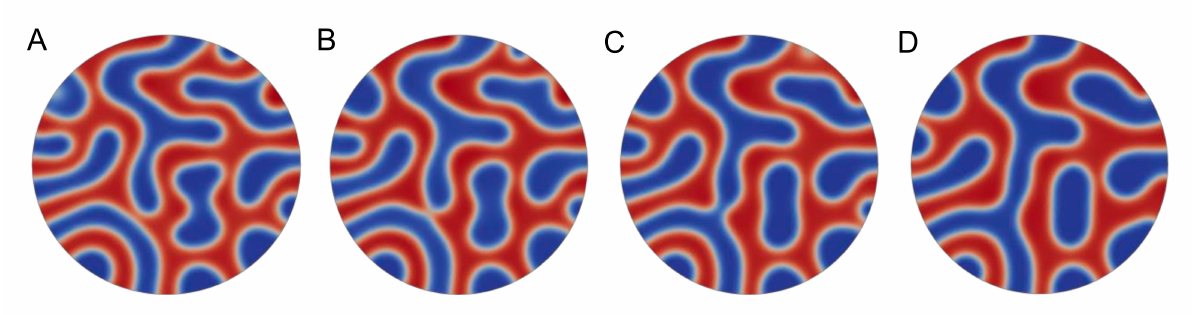
Figure 4. Calcium-free mitochondria simulation by a circle domain with a radius of four. The time step ∆ t = 0.001 for ( A ) t 750 , ( B ) t 1250 , ( C ) t 1750 , and ( D ) t 2250 . Merging and splitting of the matrix and intermembrane spaces are observed as the simulation time is lengthened.